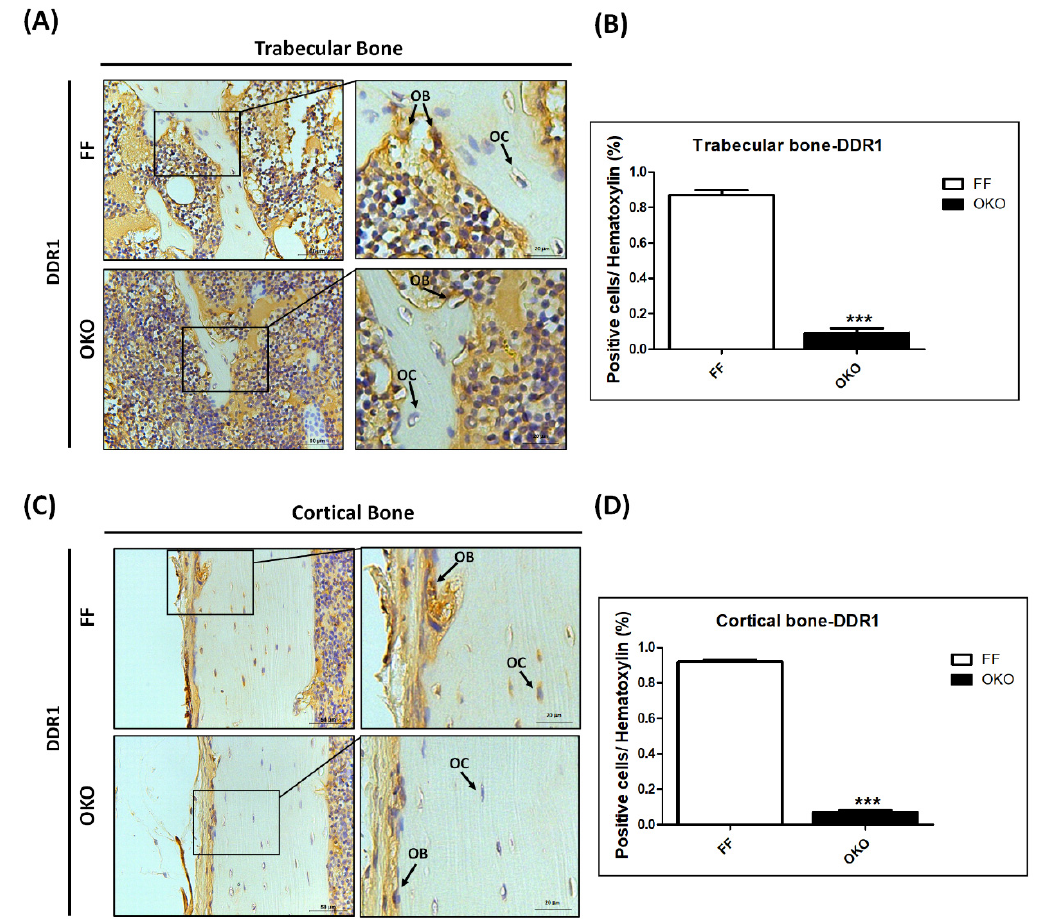
Figure 1. Ablation of DDR1 in osteoblasts/osteocytes showed a significant DDR1 protein level decrease in femoral trabecular and cortical bones. ( A ) The representative micrographs of IHC staining of DDR1 in trabecular bone. ( B ) Quantitative results of DDR1 in trabecular bone. ( C ) The representative micrographs of IHC staining of DDR1 in cortical bone. ( D ) Quantitative results of DDR1 in cortical bone; OB: osteoblasts, OC: osteocytes. The representative Micro-CT images are shown with scale bars of 50 µ m, and the zoomed-in images are 20 µ m. The positive immunolocalizations are stained dark brown. In the quantitative analysis, each bar represents the mean ± SE of eight samples in each group (*** p < 0.001 versus FF).